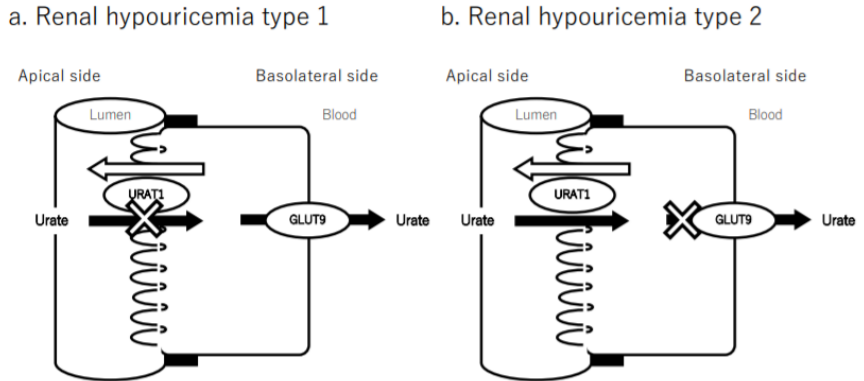
Figure 2. Transport mechanism of urate in the kidney. Urate is freely filtered at the glomerulus; most of it is reabsorbed via the urate transporter in the proximal tubule, while about one-tenth